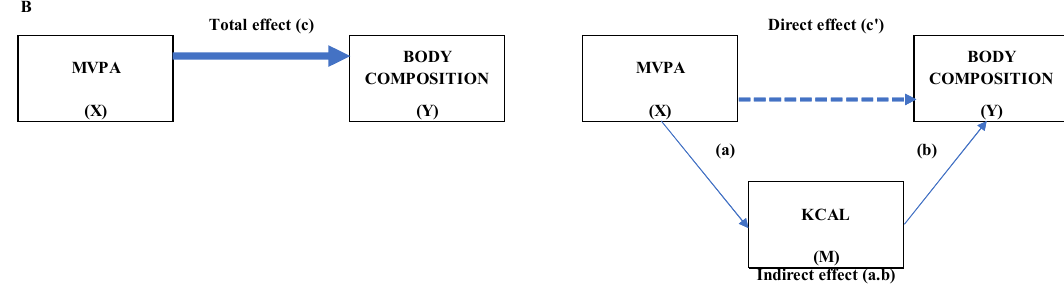
Figure 1. Conceptual models of mediation analysis: indirect effect through fitness ( A ) or kcal ( B ).